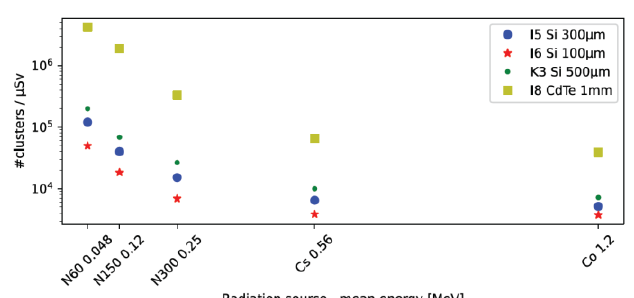
Fig. 6. Number of clusters per ambient dose equivalent as a function of the photon source